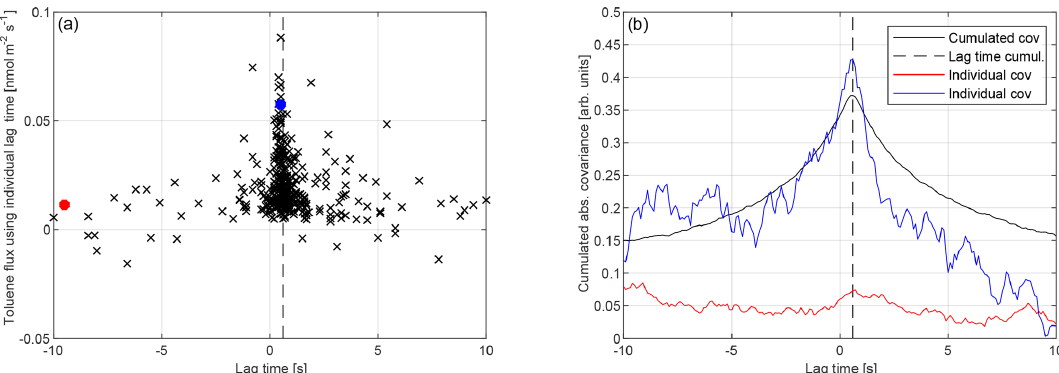
Figure 2. (a) Lag time determined from individual averaging intervals dependent on the flux. For periods of small flux, individually de- termined lag time shows large scatter. (b) Individual and cumulated absolute cross-covariance function for toluene 13 C isotope used for estimating the lag time. The dashed line shows the estimated lag time. The lag times corresponding to the individual covariance functions are shown as red and blue dots in the graph on the left.